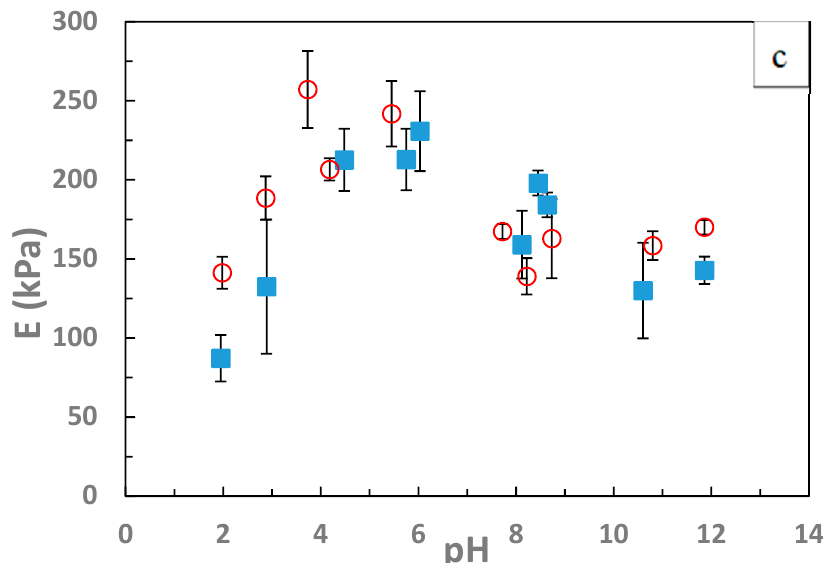
Figure 3. ( a – c ): Changes in mechanical properties with solution pH. ( a ) Ionically complexed IPNs show large improvements in failure stress and failure strain at intermediate pH, the failure properties are improved in comparison to the uncomplexed state. IPNs of PAAm/PNVF and PNVF/PAAm were partially hydrolyzed to PVAm/PAAc (blue closed symbols) and PAAc/PVAm (red open symbols).